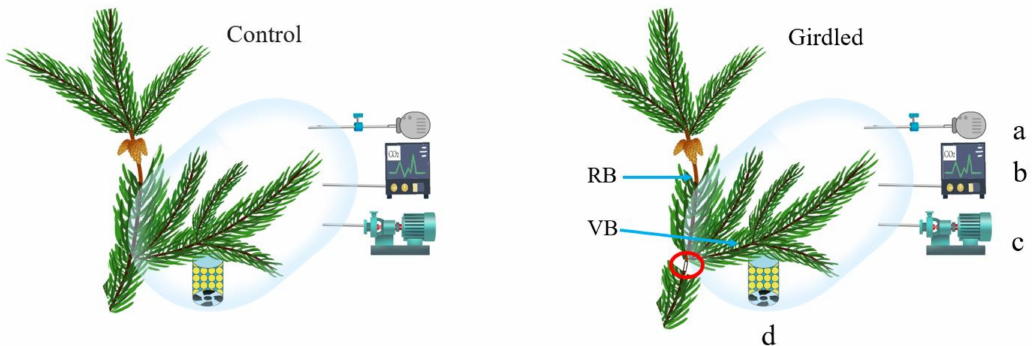
Figure 1. Scheme of the 13 CO 2 pulse labeling experiment. In each selected tree, a pair of branches were either ungirdled (Control) or girdled (Girdled; red circle) ( n = 6) at the insertion point. The lateral branch bearing no cones (i.e., vegetative branch; VB) was labeled with 13 CO 2 to evaluate potential transport of assimilated 13 C to the apical reproductive branch (RB). a: Infusion of 13 CO 2 ; b: CO 2 infrared gas analyzer; c: Infusion of CO 2 -free air, prepared by passing ambient air through soda lime; d: Electric fan with silica